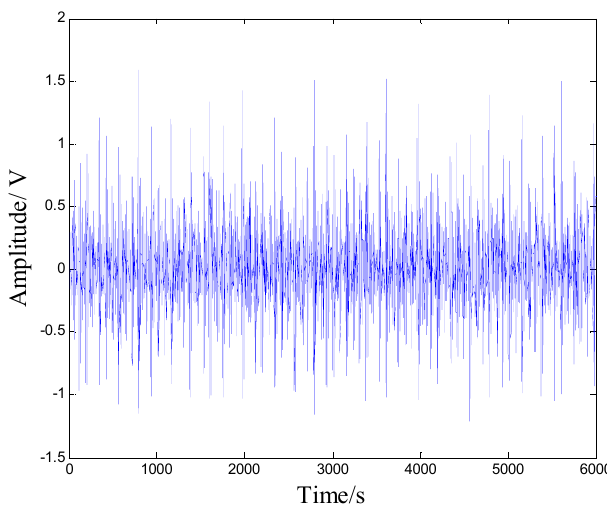
Figure 25. The time domain plot of inner race defect.